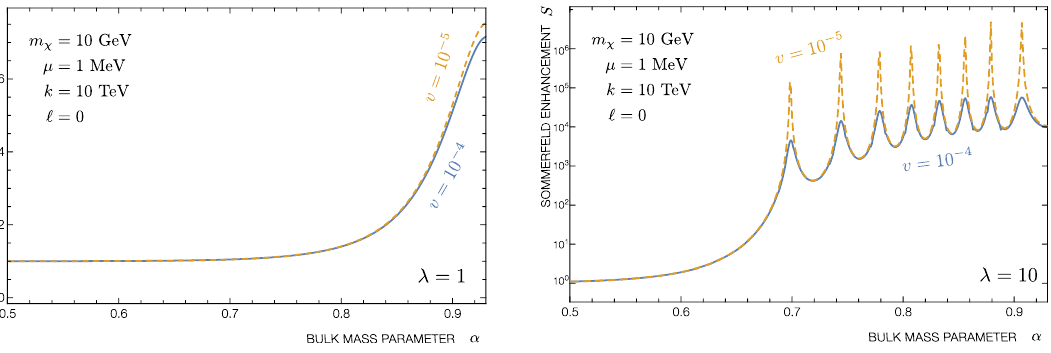
Figure 10 . Sommerfeld enhancement of the ‘ = 0 partial wave as a function of α . relative to the dark matter mass, µ/m for α ∼ 0 . 66